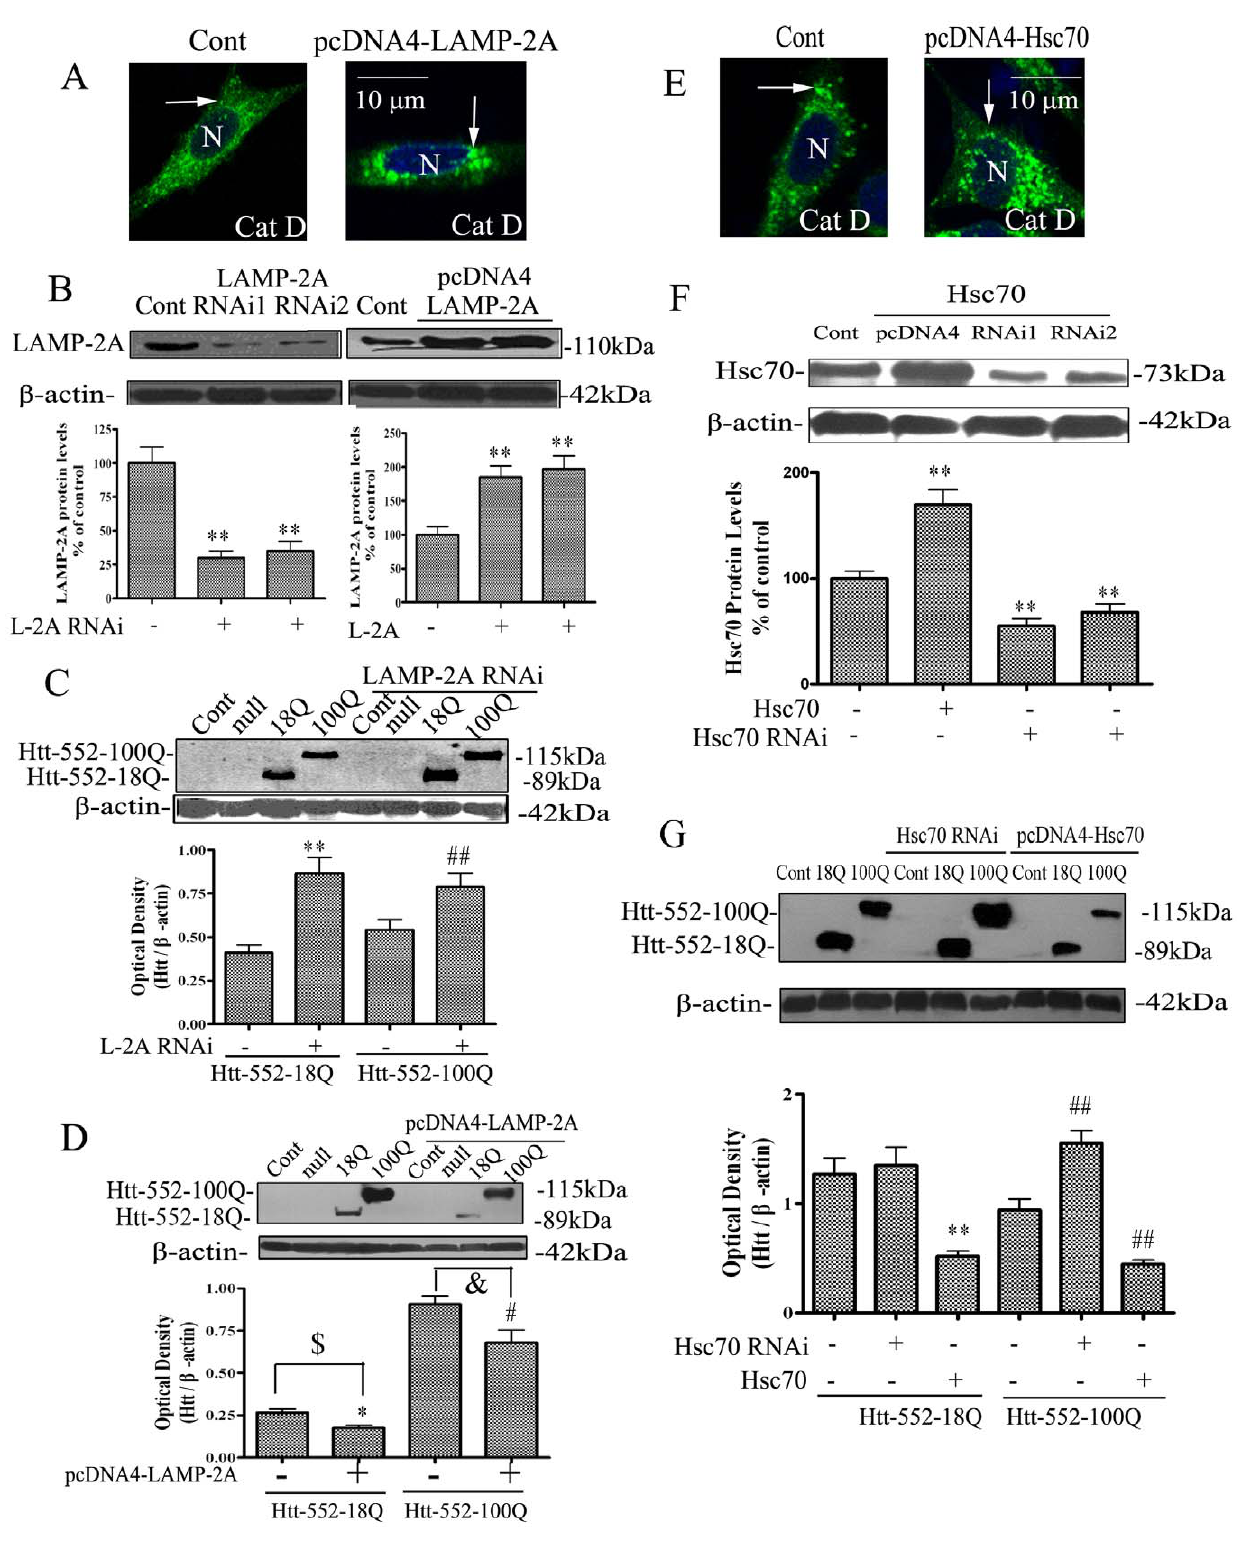
Figure 3. Change in CMA related proteins affects the accumulation of Htt-552. (A) Redistribution of CMA-active lysosomes induced by overexpression of LAMP-2A. PC12 cells were transfected with PCDNA4-LAMP-2A for72 h. Lysosomes were labeled with immunofluorescence of Cathepsin D (green) and the increased perineuclear localization of CMA-active lysosomes was observed. N: nucleus. Thin arrows point to lysosomes. The scale bar=10 m m. (B) The efficiency of knockdown and overexpression of LAPM-2A. PC12 cells were transiently cotransfected with LAMP-2A plasmid or LAMP-2A siRNA for 48 h. Lysates were subjected to Western blot analysis with anti–human LAMP-2A. Values are the mean 6 SE of three independent experiments. **P , 0.01 (compared with control); ## P , 0.01 (compared with Htt-552-100Q with control). (C) and (D) Effects of